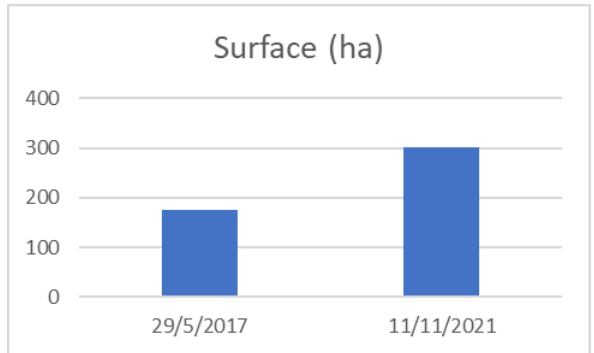
Figure 8 . Surface increase from 2017 to